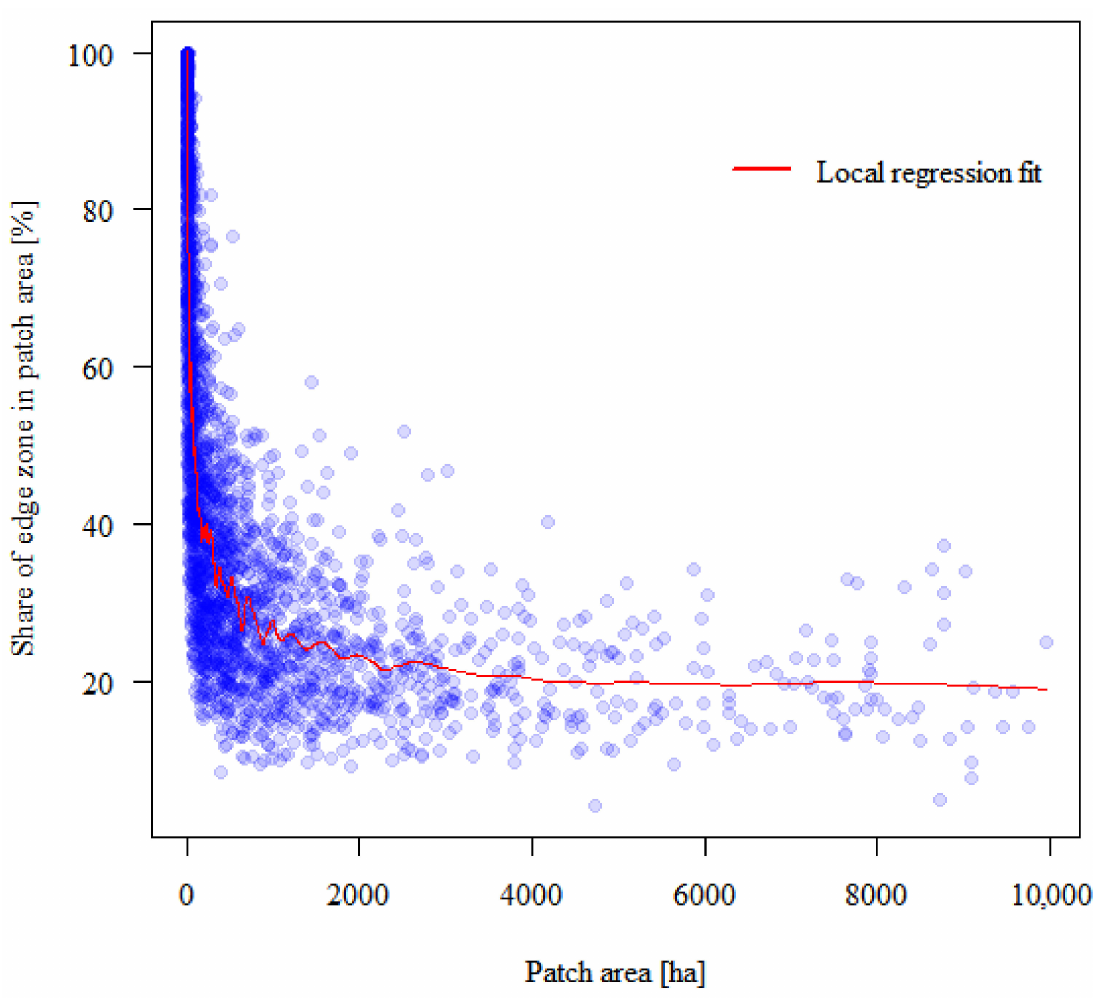
Figure 9. Local regression model determining the impact of the area of a forest patch on the percentage of the edge